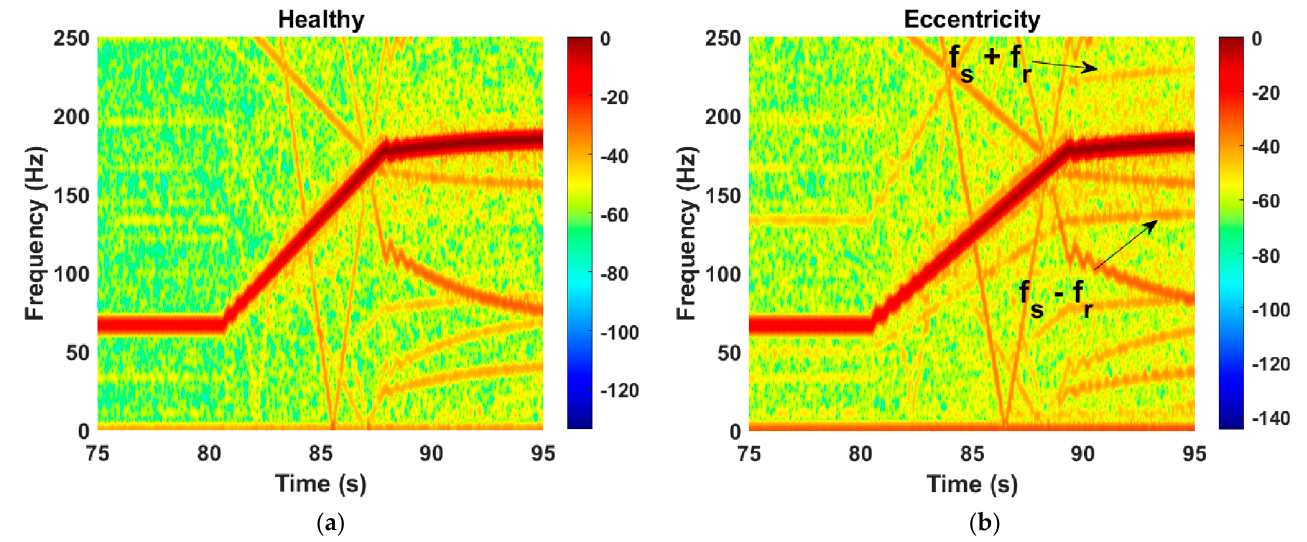
Figure 5. STFT analysis of PMSM, ( a ) Healthy motor and ( b ) motor with eccentricity.